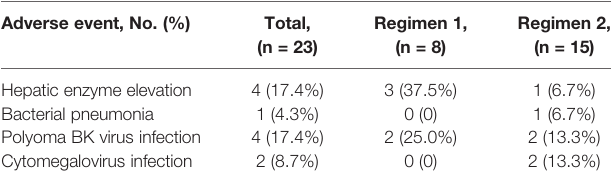
TABLE 3 | Adverse events of cABMR patients treated with BM-MSCs. Adverse event, No. (%)